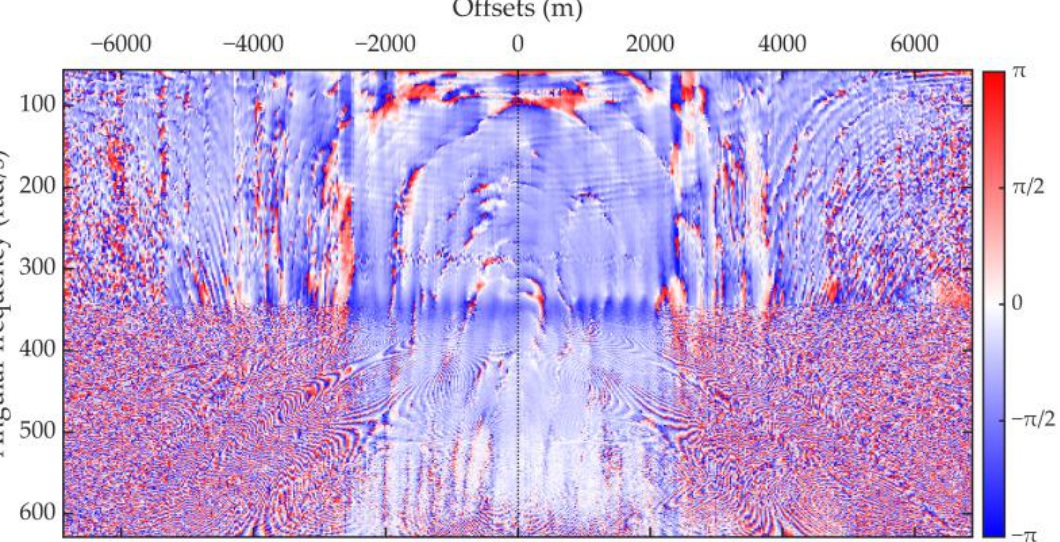
Figure 4. 2D phase spectrum of composite P / v z calibration filter. To fully fit the definition of the ω domain, here we use angular frequency as the y -axis, and the unit of the left-hand labels is rad/s, not Hz. The phase angle is denoted by radian, not degree. A slight outlier-removal algorithm is applied to the 2D phase spectrum.